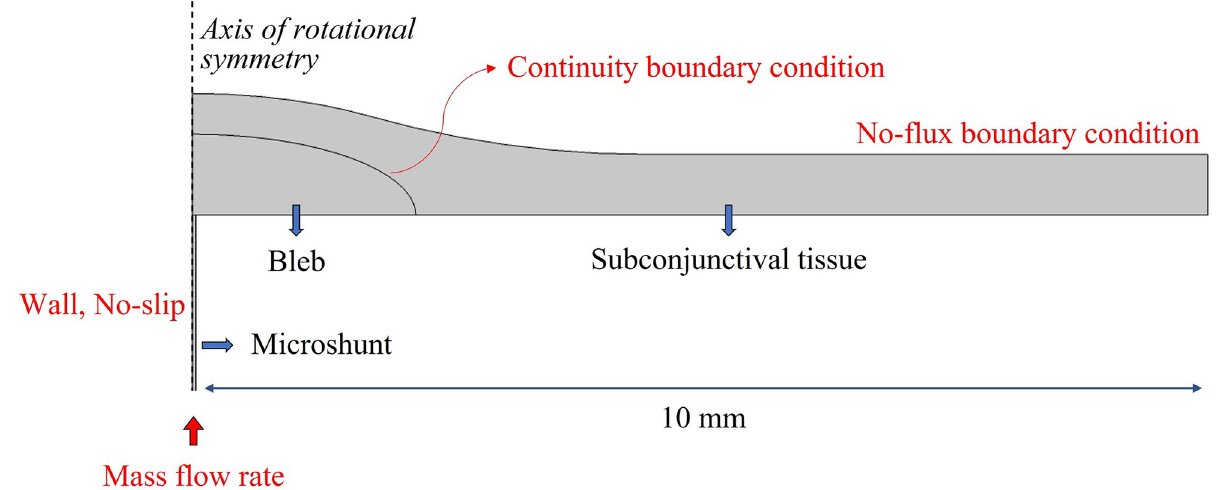
Fig 4. 2D-axisymmetric computational domain of the subconjunctival drainage of aqueous humor through a hollow tube-like microshunt. The bleb dimensions are as in Fig 3 and a scar tissue layer may be included as in Fig 3B. The applied boundary conditions are indicated in red.